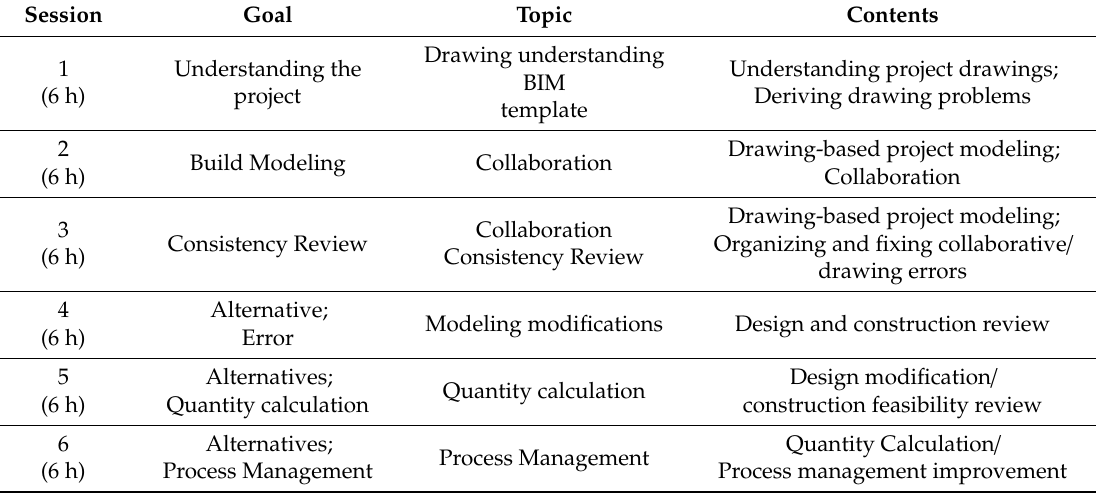
Table 5. Program goals and